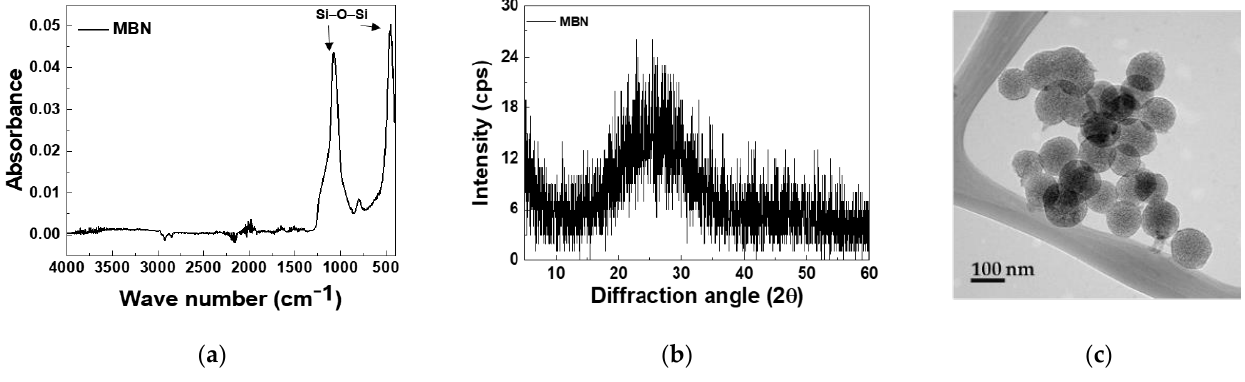
Figure 2. Micro CT images of the resin discs; ( a ) control (SAR); ( b ) SAR + 1% MBN; ( c ) SAR + 3% MBN; and ( d ) SAR + 5% MBN.